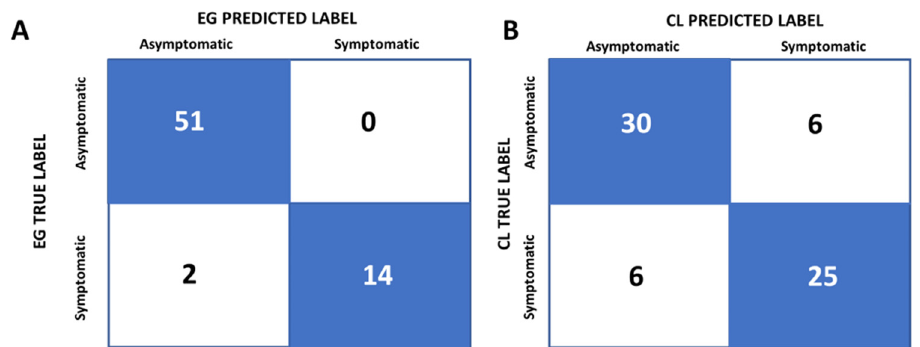
Figure 2. Confusion matrix for the classification of young eyeglasses (EG) ( A ) and contact lens (CL) ( B ) wearers as asymptomatic or symptomatic using OSDI D scores (true label) and logistic regression prediction (predicted label). The number of subjects was shown inside each box.